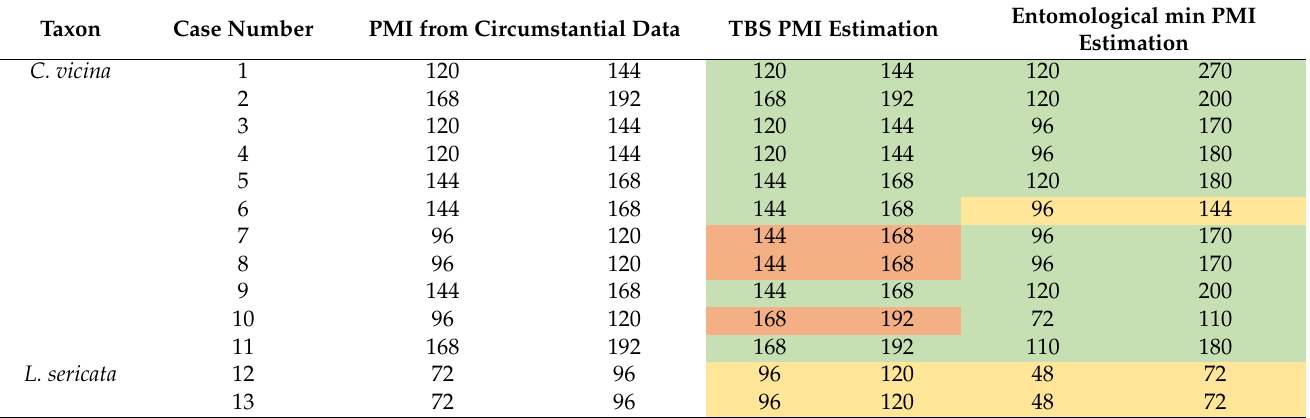
Table 2. Comparison between the circumstantial data estimation and technical assessment using accumulated degree-days (ADDs) converted in a 24 h